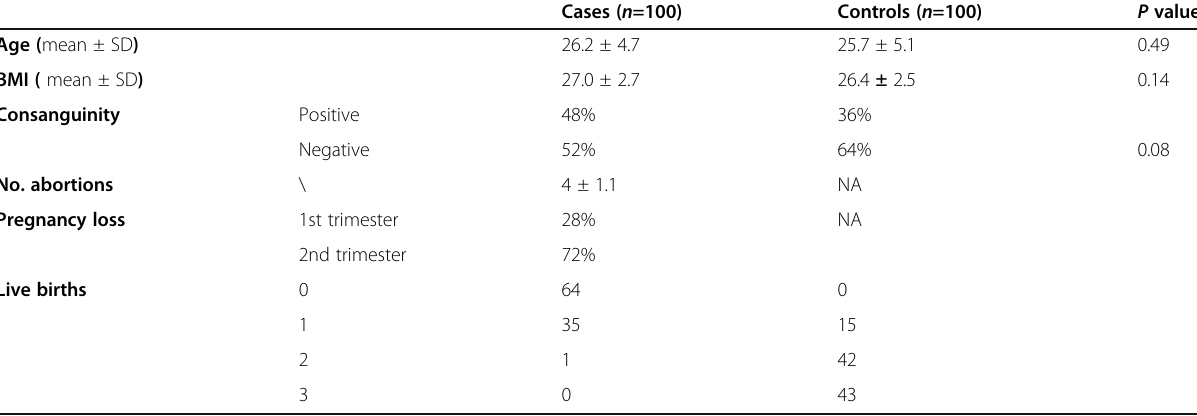
Table 1 Descriptive characteristics among RPL patients and